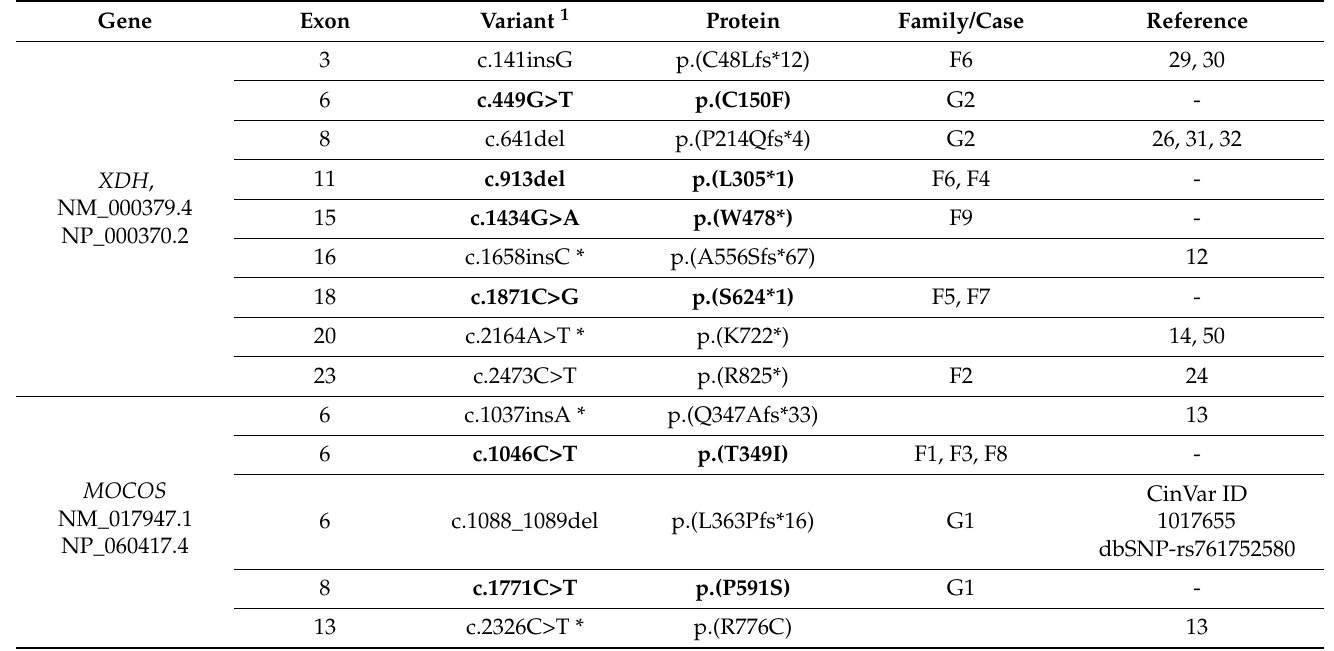
Table 2. Variants causing classical xanthinuria identified in patients referred to the Tel Aviv Medical Center between the years 1997 and 2013. Gene Exon Variant 1 Protein Family/Case Reference